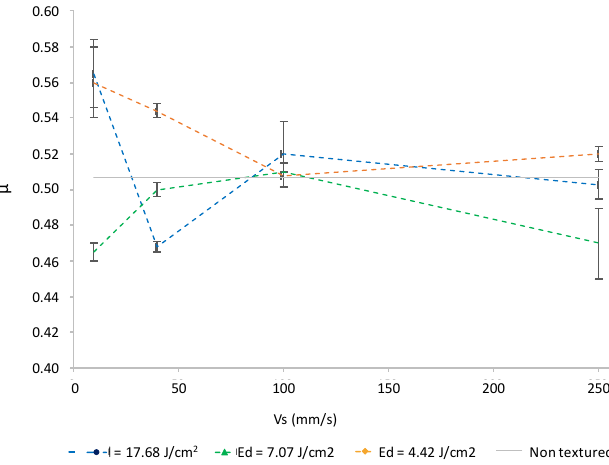
Figure 4. Friction coefficient behavior as a function of V s .